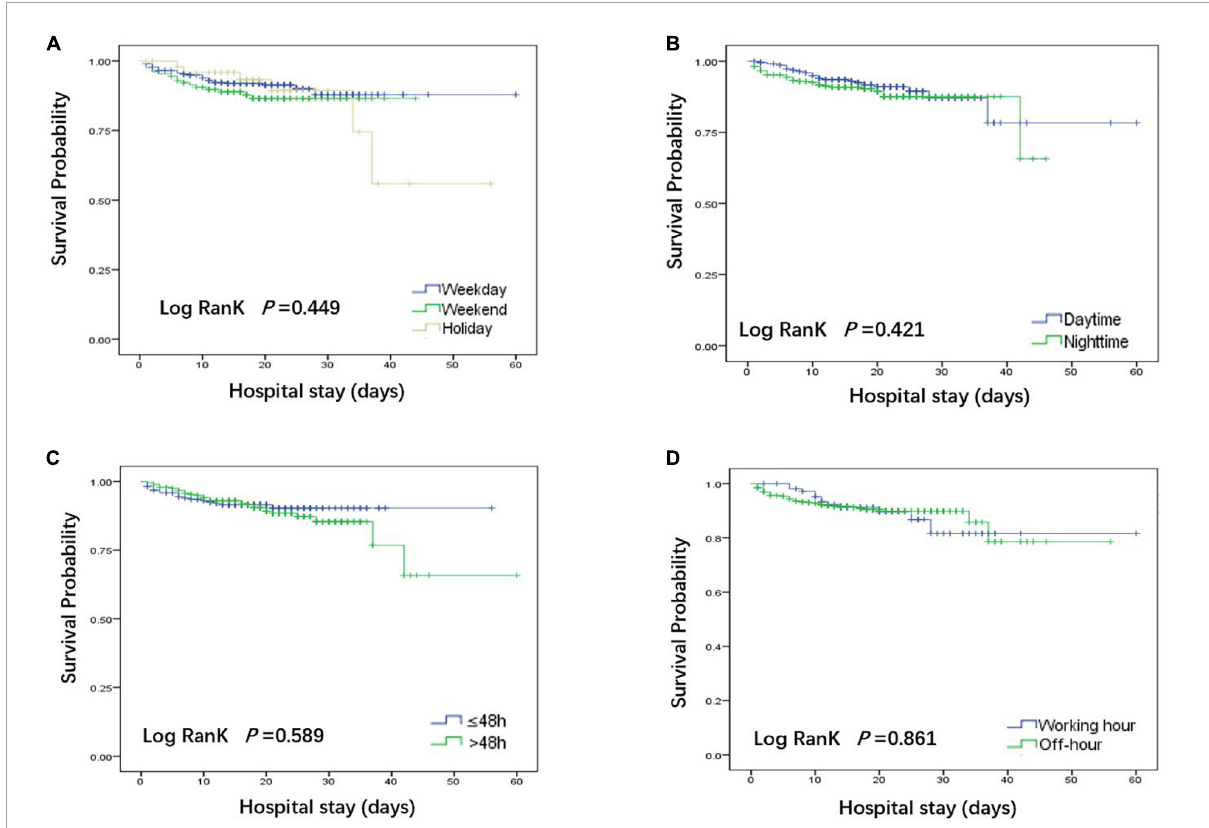
FIGURE3 Kaplan-Meier curves were used to compare the in-hospital deaths of patients in each group. (A) Comparison of patients undergoing weekdays, weekends and holidays; (B) Comparison of patients undergoing daytime and nighttime surgery; (C) Comparison of patients with surgical intervention times ≤ 48 h and > 48 h. (D) Comparison of patients undergoing working hours and off-hours.